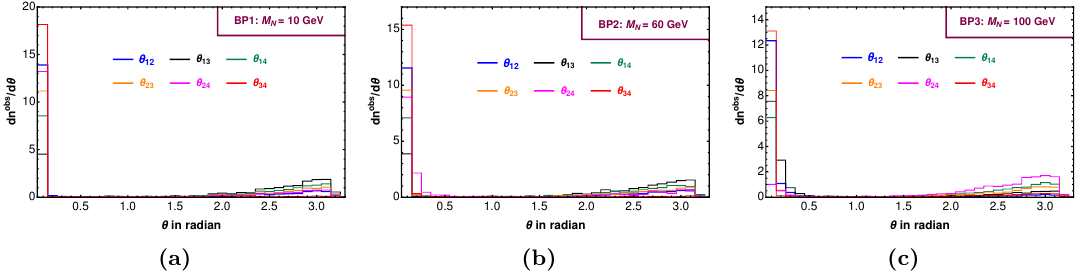
Figure 5. The angular distribution ( θ ) of the angles between two leptons at the LHC with the centre of mass energy of 14 TeV and the integrated luminosity of 3 ab − 1 for the benchmark